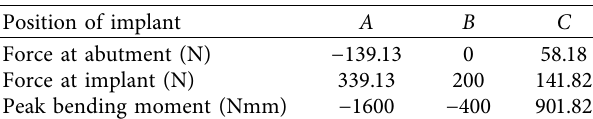
Figure 5: Differences in microstrain values when the load was increased from 150N to 200 N. Table 3: Shear forces and peak bending moments developed in the free-body